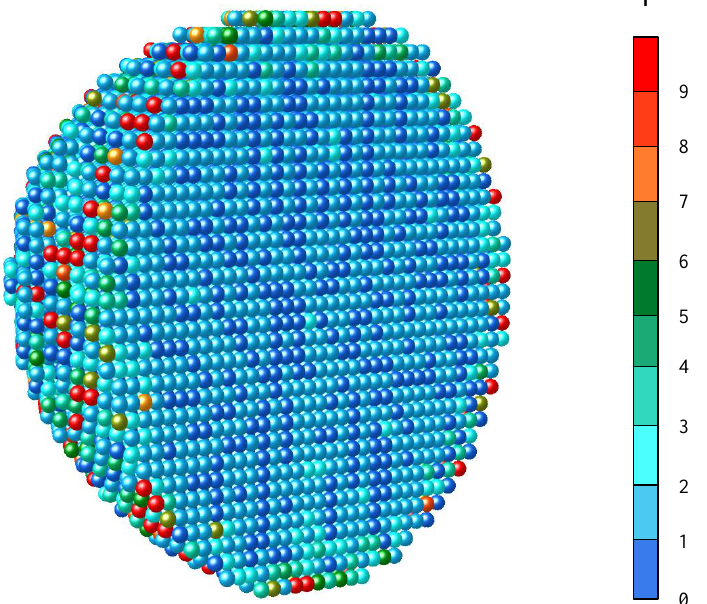
Figure 16. The r of the OAA index prediction model of each reachability sphere.